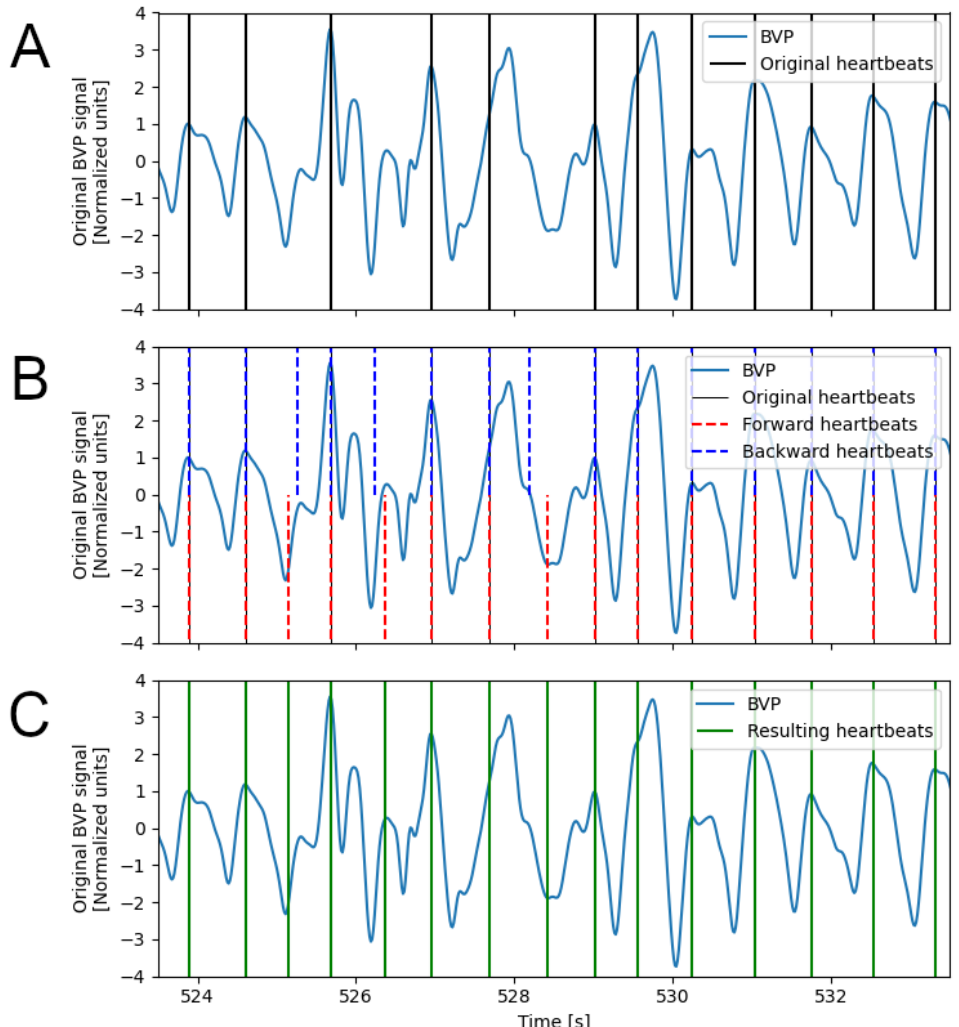
Figure 3. Steps of the RCO algorithm; portion of BVP signal affected by motion artifacts. ( A ) Original BVP signal with the heartbeats detected by the DBD algorithm; ( B ) Results of the AEDP on the forward and backward direction to identify missed peaks and detection errors; ( C ) Results of the RCO with heartbeats selected by the combinatorial optimization of the candidate heartbeats from the